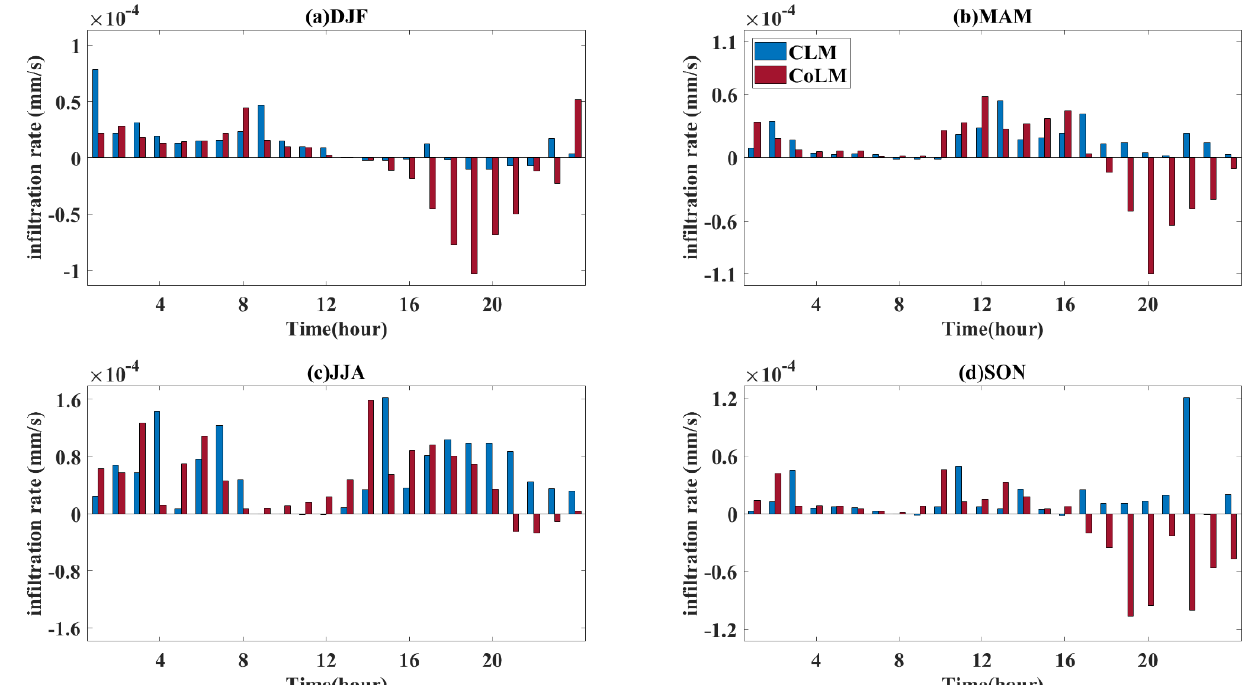
Figure 12. Diurnal variation in the infiltration rate simulations at the Little River site, with CLM5 simulations in blue bars and CoLM2014 simulations in red bars, for ( a – d ) for winter, spring, summer, and autumn, respectively.